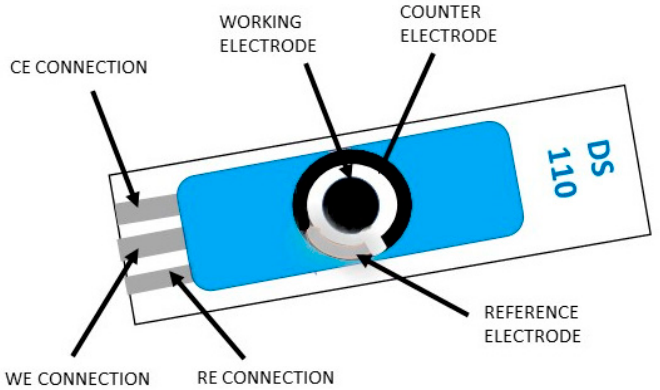
Figure 1. Electrode module used for electrochemical analysis.